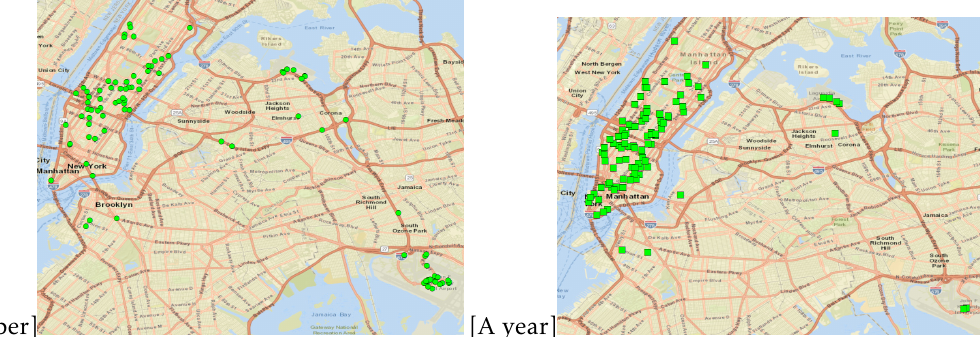
Figure 8. Top 100 longest distance